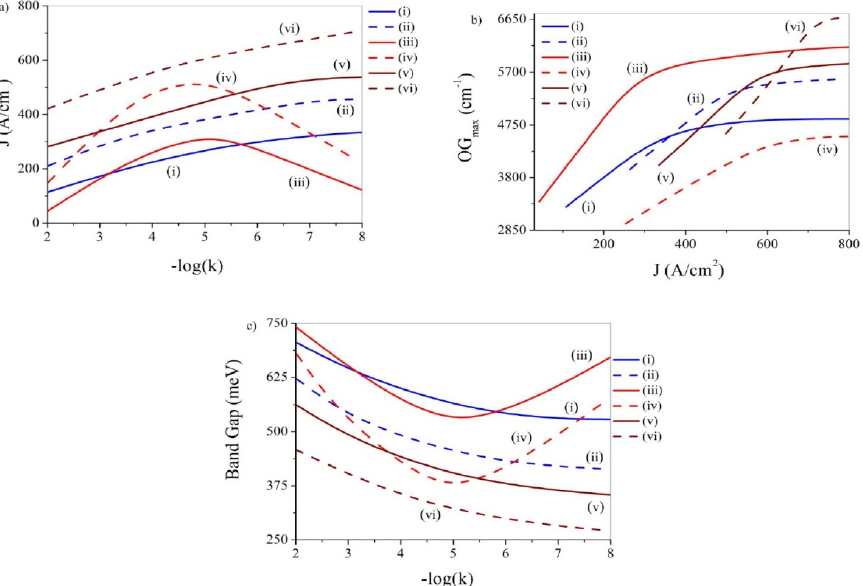
Figure 19. Plots of ( a ) J vs. − log(k), ( b ) OG peak vs. J and ( c ) band gap vs. − log(k): (i) without noise and under OPA, (ii) without noise and under EPA, (iii) with ADWN and under EPA, (iv) with ADWN and under EPA, (v) with MLWN and under OPA and (vi) with MLWN and under EPA. Figure 20a,b discerns the OG plots over a range of h υ for three different values of the noise strength ζ (10 − 10 , 10 − 6 and 10 − 2 ) for ADWN and MLWN, respectively, both with OPA and EPA. In all these diagrams k assumes the fixed value of 10 − 6 . With OPA and both with ADWN and MLWN the OG peak at first undergoes blue-shift with an increase in ζ up to ζ ~10 − 6 followed by a red-shift as ζ is increased further. Furthermore, the OG peak height also shows maximization (minimization) at ζ ~10 − 6 under applied ADWN (MLWN). Under EPA the OG peak undergoes red-shift as ζ increases both with ADWN and MLWN. However, the peak height manifests persistent rise (fall) with an increase in the noise strength under applied ADWN (MLWN). Figure 20c depicts the plots of OG peak values against ζ under applied ADWN and MLWN, both with OPA and EPA for k = 10 − 6 . In the presence of OPA the OG peaks display distinct maximization (minimization) at ζ ~10 − 5 under applied ADWN (MLWN). However, with EPA, the said peak values divulge steady rise (fall) as ζ enhances under applied ADWN (MLWN). In all situations, the OG peaks approach their respective noise-free val- ues when the noise strength becomes extremely small.